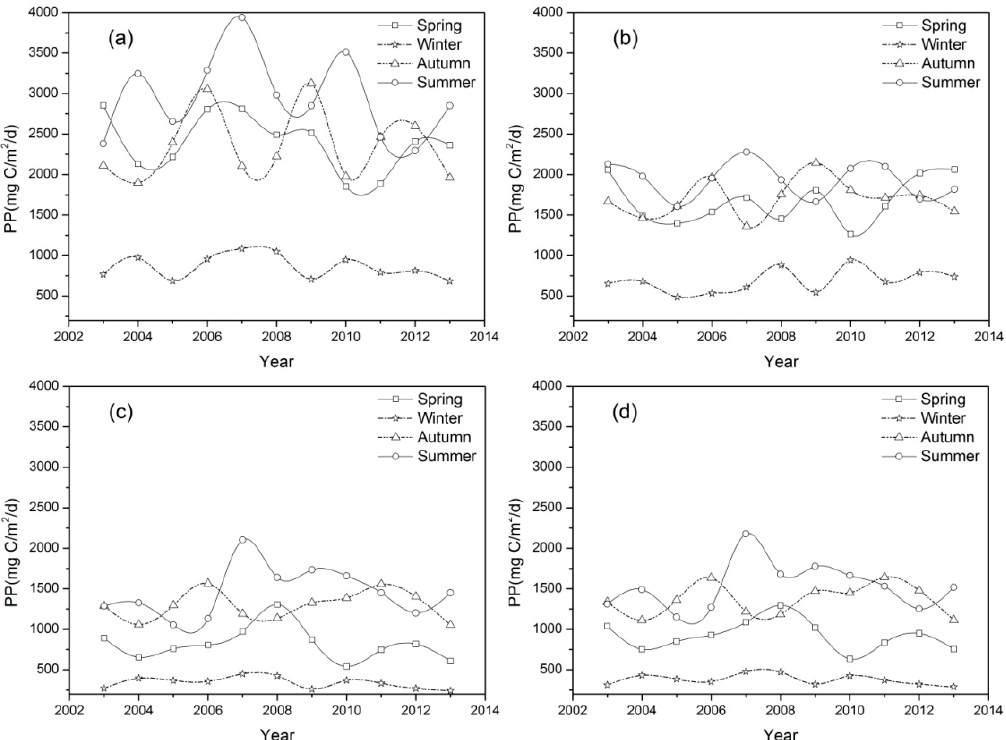
Figure 5. Seasonal variation of phytoplankton primary production in each region based on VGPM estimation from 2003 to 2013 in ( a ) Zhanshan Bay; ( b ) Meiliang Bay; ( c ) the open area and ( d ) the entire lake.